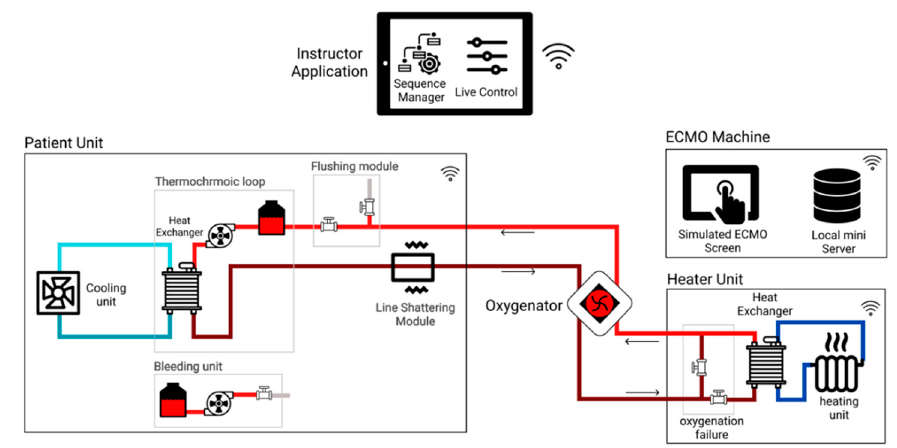
Figure 2. Overview of the ECMO simulation system.